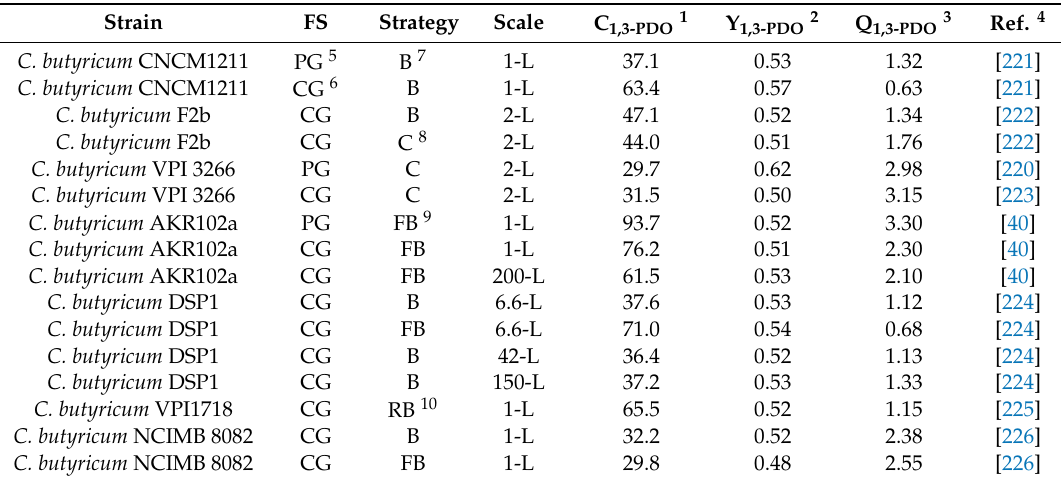
Table 5. Production of 1,3-PDO from glycerol using di ff erent Clostridium butyricum strains and